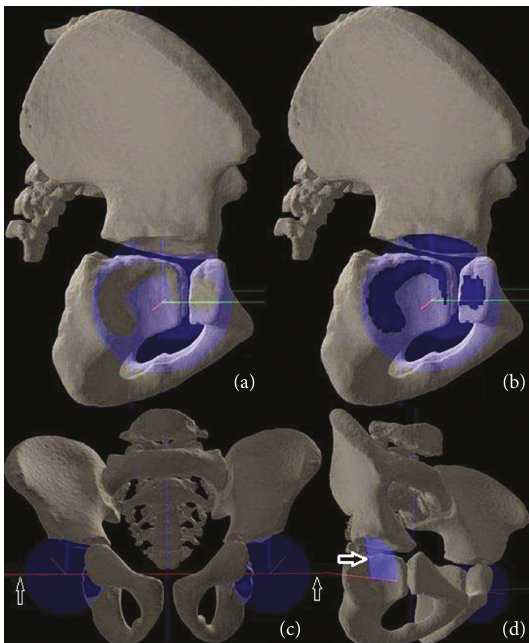
Figure 1: The process of FH coverage assessment by the acetab- ulum. (a) the virtual sphere; (b) the contact spot between the sphere and acetabular edge; (c) the reference line (arrows); (d) an inter- section angle (arrow).